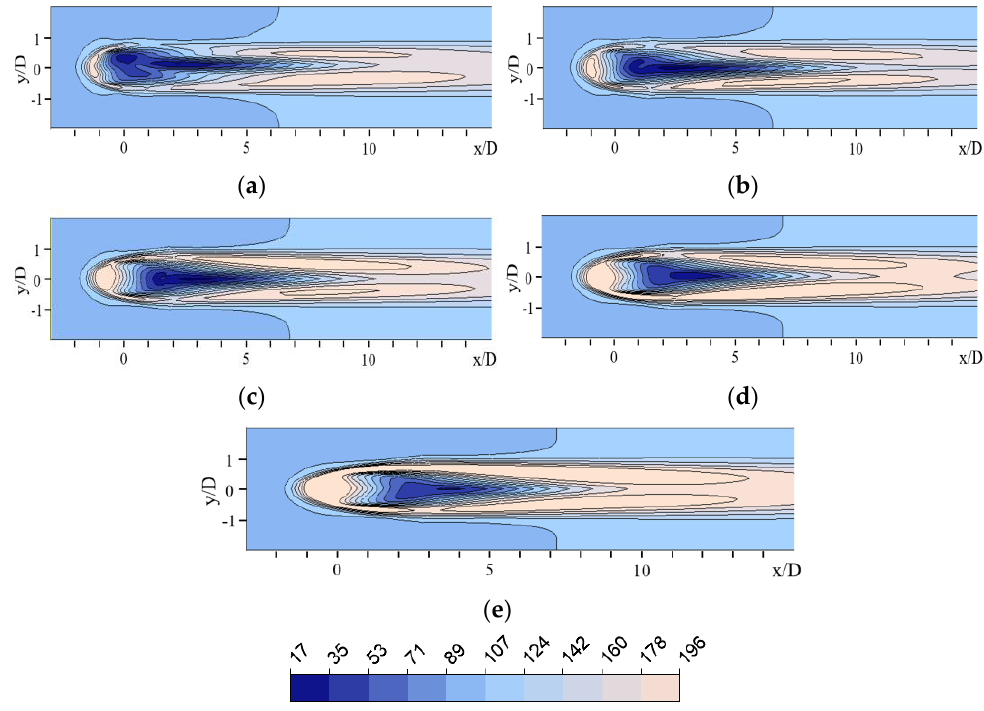
Figure 16. Turbulent kinetic energy distributions on the x-y plane at z/D = 0.2 (unit: m 2 / s 2 ): ( a ) reference, ( b ) B2 = 1.5D, ( c ) B2 = 2D, ( d ) B2 = 2.5D, ( e ) B2 = 3D.